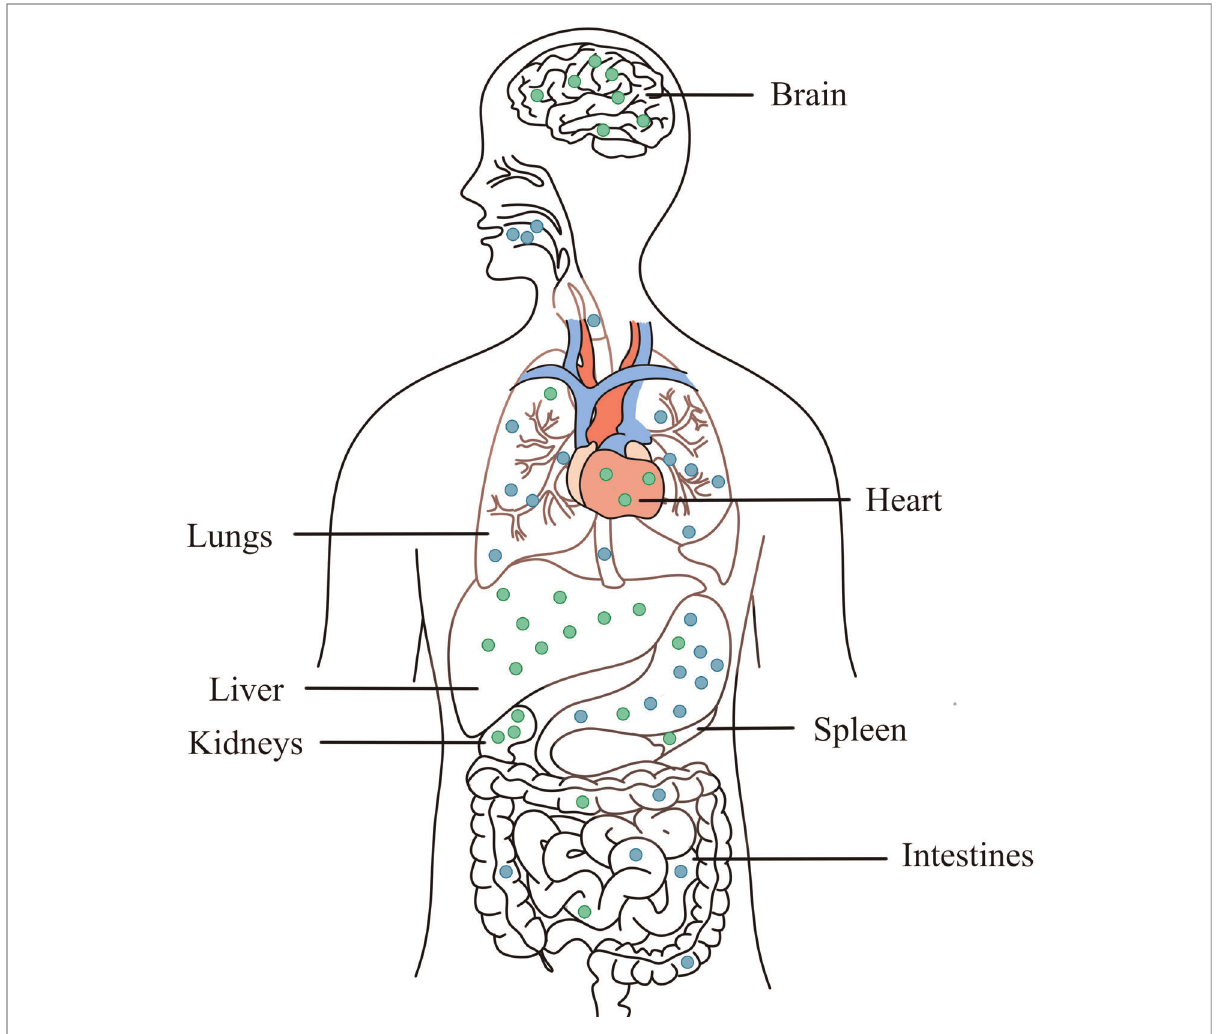
FIGURE 4 Main routes of transfer (blue) and accumulation (green) in organs of copper-containing NPs in the body through oral